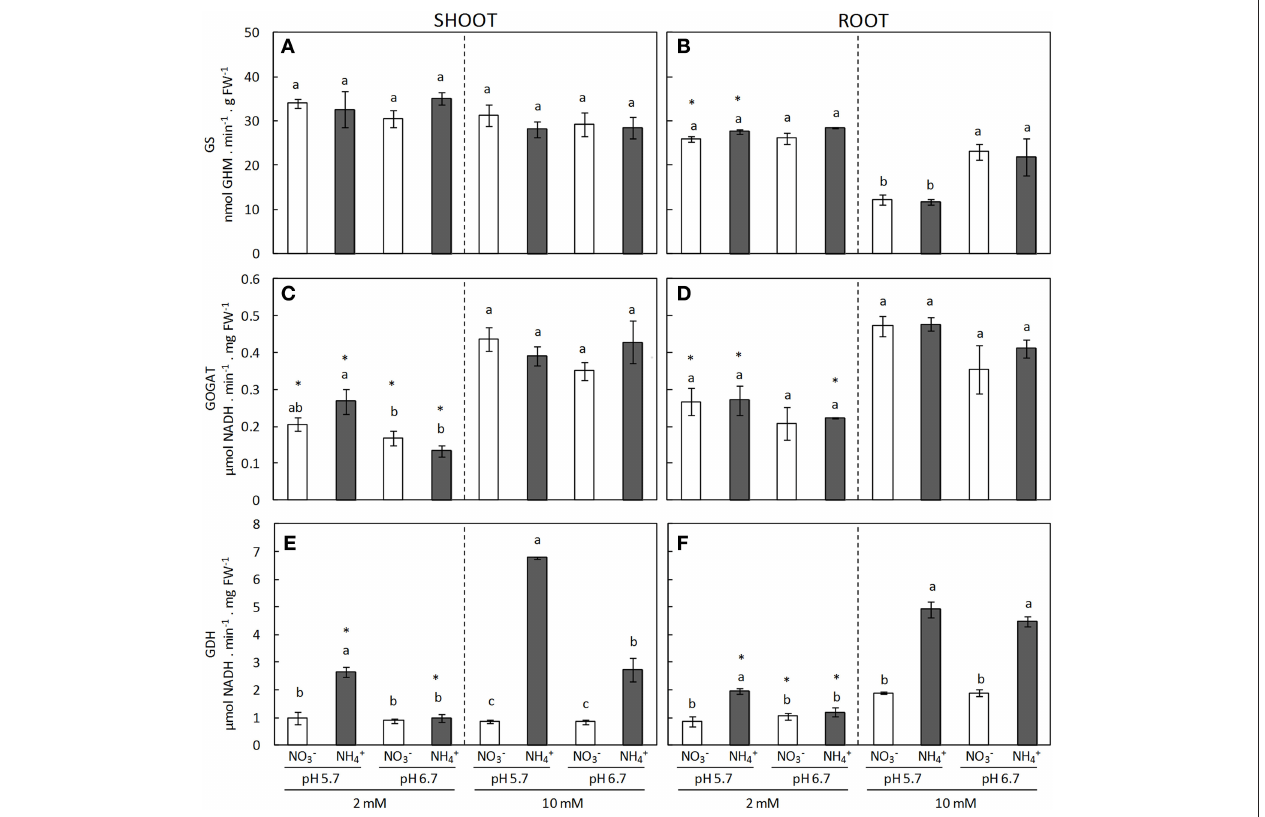
FIGURE 3 | GS (A,B), GOGAT (C,D), and GDH (E,F) enzyme activities from shoots (A,C,E) and roots (B,D,F) of plants grown under different conditions of pH (5.7 or 6.7), N source (NO − 3 or NH + 4 ) and concentration (2 or 10mM). Statistical analysis was described in Figure 1 . Columns represent mean ± se ( n = 3 –6). Each sample is a pool of three